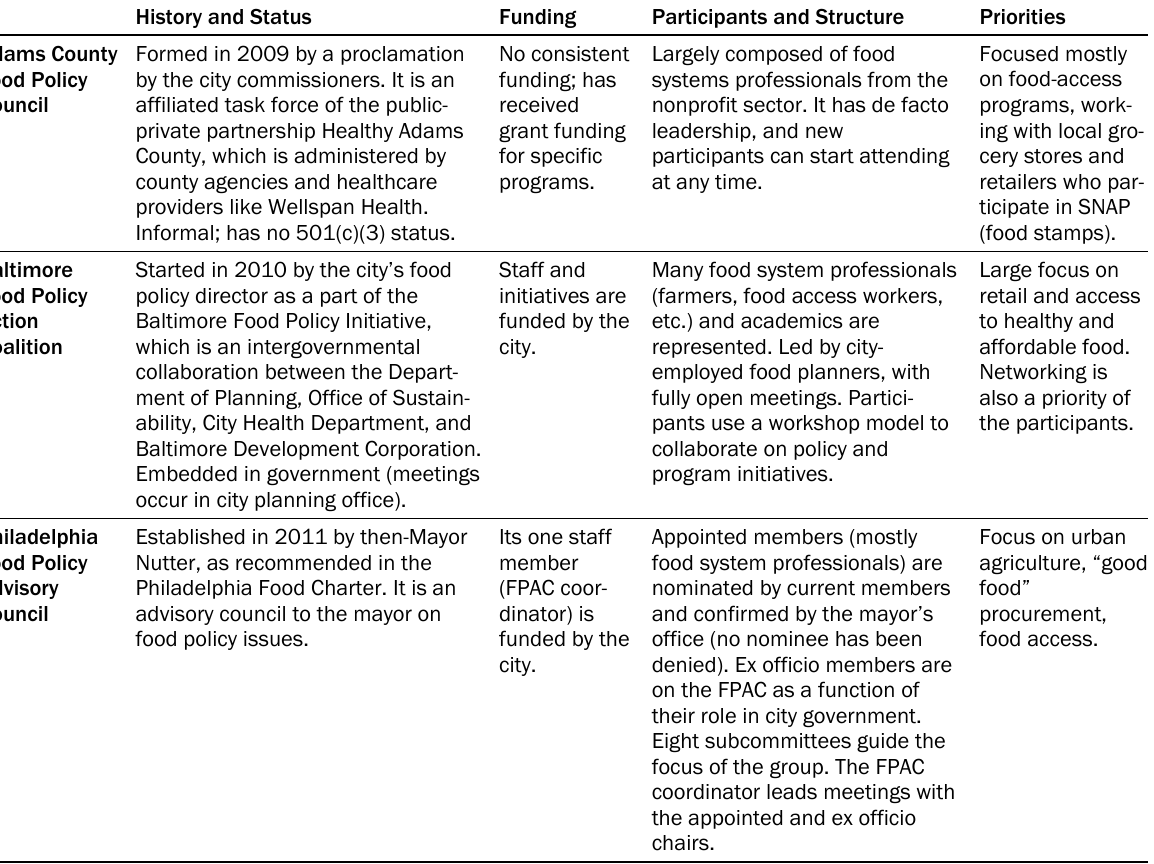
Table 1. Background Information on Food Policy Council